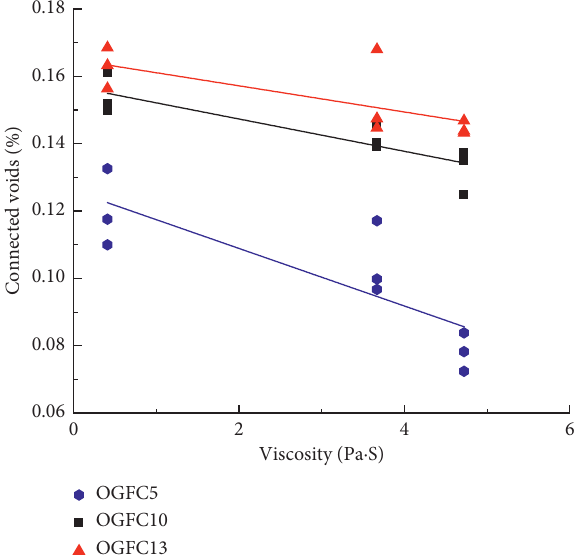
Figure 5: Relation between viscosity and connected voids ratio.